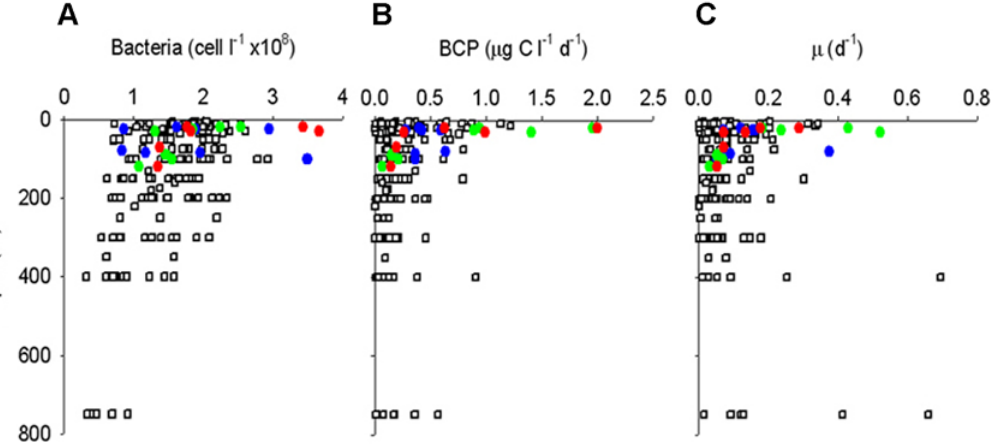
Figure 2. Depth profile of bacterial parameters in summer 2004 and winter 2006. Winter data are from 32 stations from 5 to 400 m; at 6 stations samples were also taken from 750 m. Summer: blue circles=ACC water; red circles=shelf water; green circles=mixed water; empty square=Winter. (Panel A) Bacterial abundance; (panel B) BCP=bacterial carbon production; BCP calculated from 3 H-Leucine incorporation, employing a conversion factor of 3.1 kg C per mol of Leu [17]; (panel C) m =bacterial growth rate. Cell-specific growth rate calculations assumed 20 fg C per cell